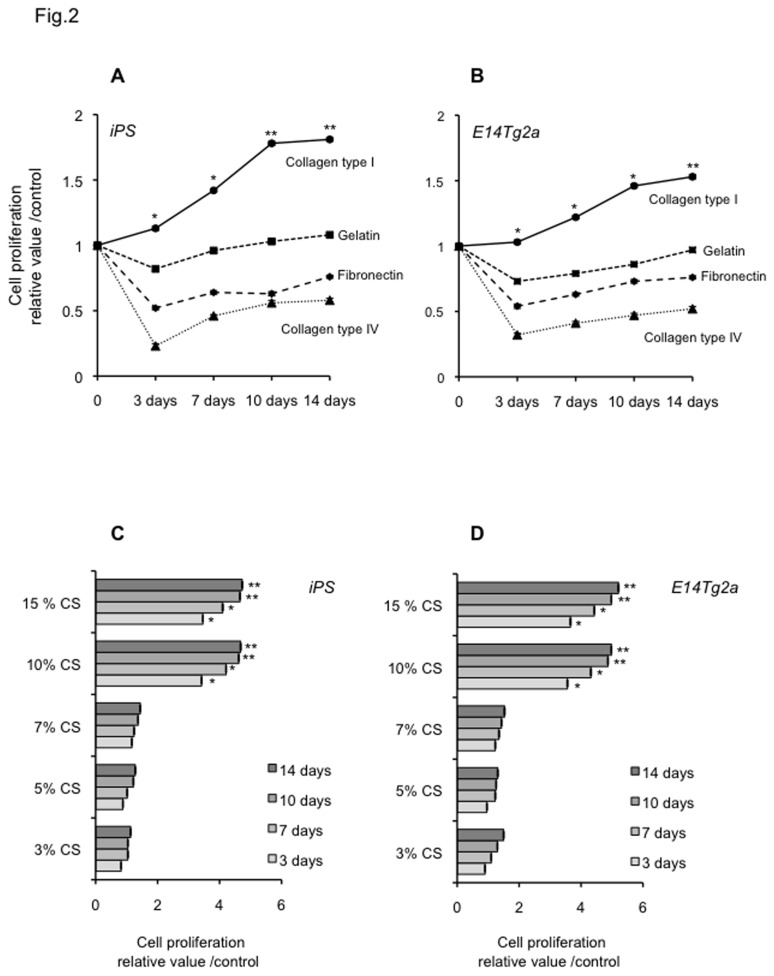
Optimization of ECM components required to differentiate iPS cells into odontoblast-like cells.To evaluate the effect of extracellular matrix (ECM) components on the proliferation of embryoid bodies derived from iPS (A) and E14Tg2a ES cells (B), we cultured these cells on various ECM proteins for 14 days, examining cell proliferation at various time points during this period using a BrdU-based cell proliferation ELISA. Data are the degree of cell proliferation normalized against the number of proliferating cells at the start of the assay period (fold of control). Statistically significant increases in proliferation are shown by * and ** (P < 0.05 and P < 0.01, respectively, vs. control). The optimal concentration of collagen scaffold was also determined by growing iPS (C) and E14Tg2a (D) cells for 14 days in
vitro on plates pretreated with various concentrations of CS (3%, 5%, 7%, 10%, or 15% Col-I). Proliferation was measured at various time points using a BrdU-based ELISA, as above. Data are the mean ± SD of three independent repeats. Differences between untreated and the various CS-treated groups were assessed using a Mann-Whitney U-test (*P < 0.05; **P < 0.01, vs. untreated).